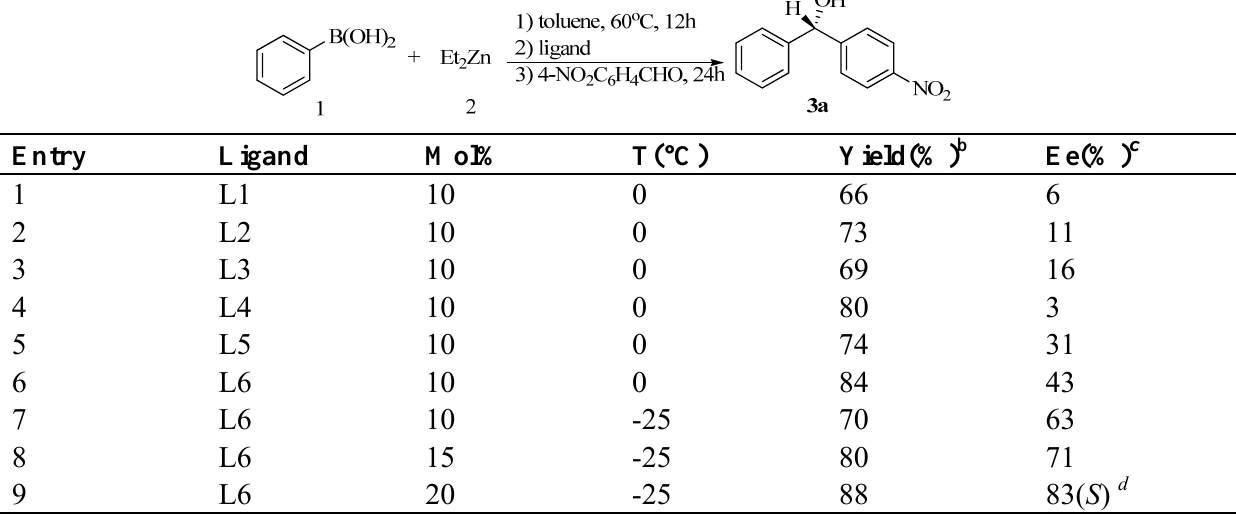
Table 1. Asymmetric Phenyl Transfer to 4-nitrobenzaldehyde .